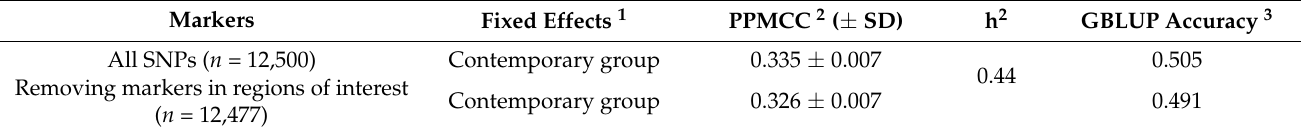
Table 3. Summary statistics from K-fold (K = 5) cross-validation with random sampling ( n = 50 iterations).